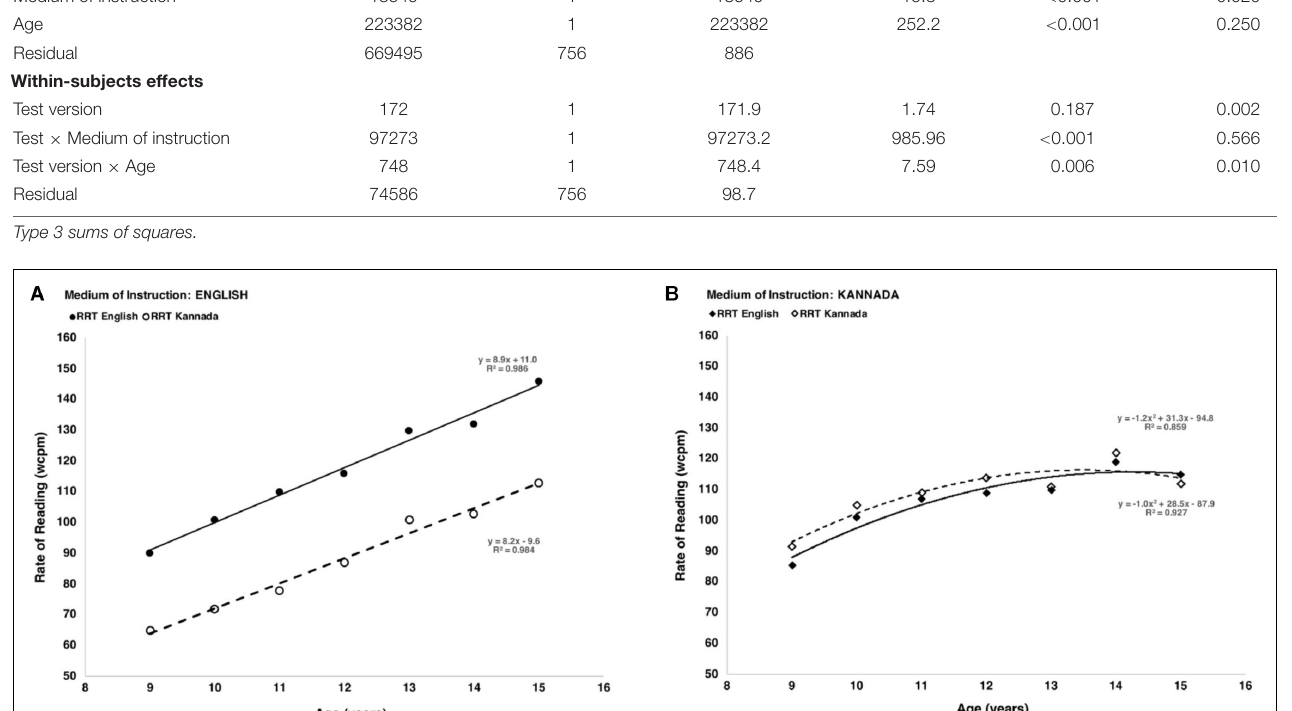
FIGURE 2 | Effect of age and medium of instruction ( A – English, B – Kannada) on rate of reading.